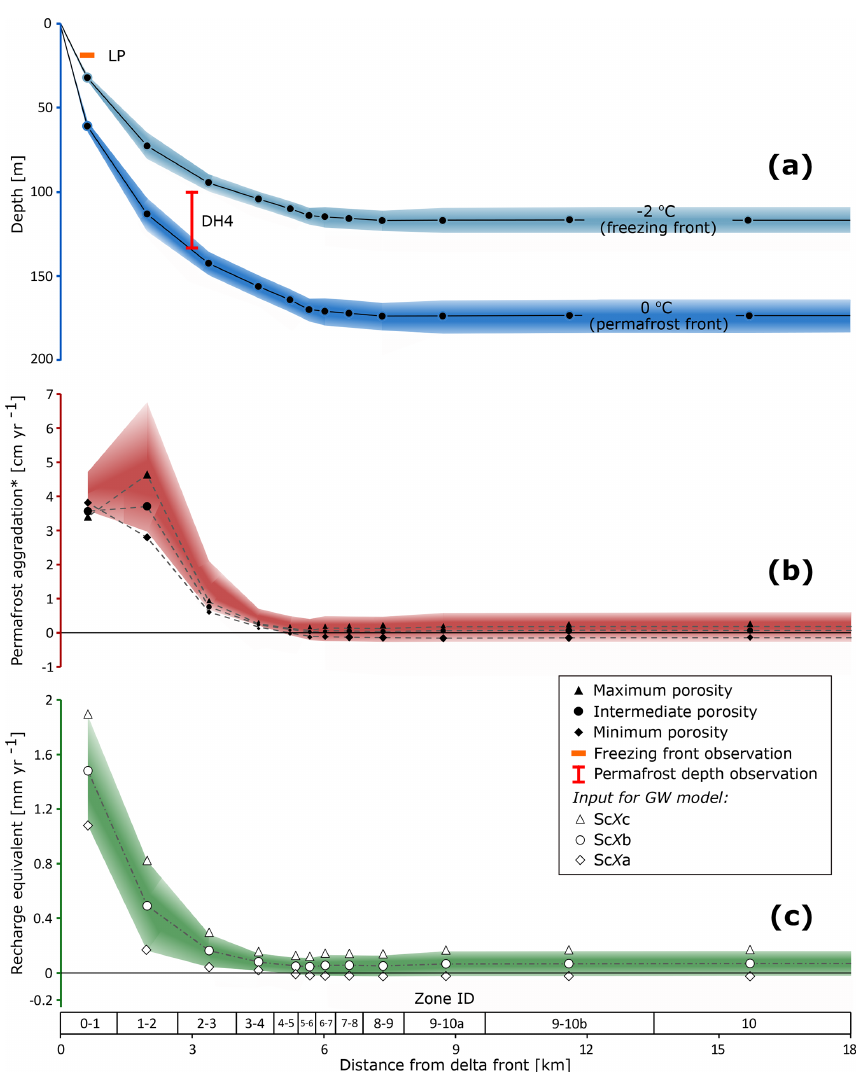
Figure 7. Present-day permafrost conditions as simulated by the 1DHT model. (a) Freezing front and permafrost depths. The upper and lower edges of the shaded area correspond to the maximum and minimum limits of the porosity range, while the curve and the points correspond to the intermediate limits (Table 2). Permafrost depth and freezing front depth observations are from Braathen et al. (2012) and Harada and Yoshikawa (1996), respectively. (b) Rate of permafrost aggradation. The point symbols represent the present permafrost aggradation, while the shaded area is drawn by applying a time-moving average, as described in Sect. 4.3.4, and represents the values used to calculate the equivalent recharge rates. * The − 0 . 7 ◦ C isotherm, which has been used to calculate this, since the greatest phase change rate takes place at that temperature. (c) Equivalent recharge rate (net rate of loss in pore space). The points on the curve and the outer edges of the shaded area represent the recharge rates, which were assigned to the corresponding zones in the groundwater